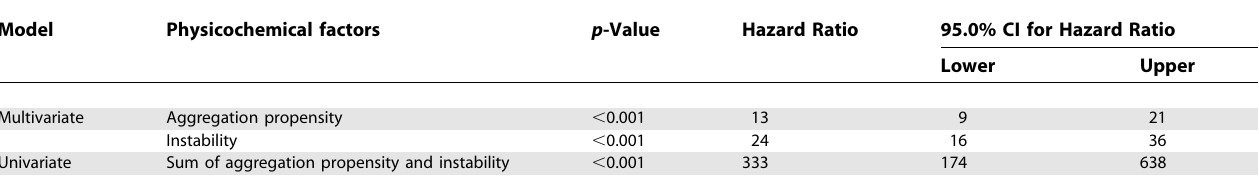
Table 5. SOD1 Variants’ Aggregation Propensity and Instability Are ALS Risk